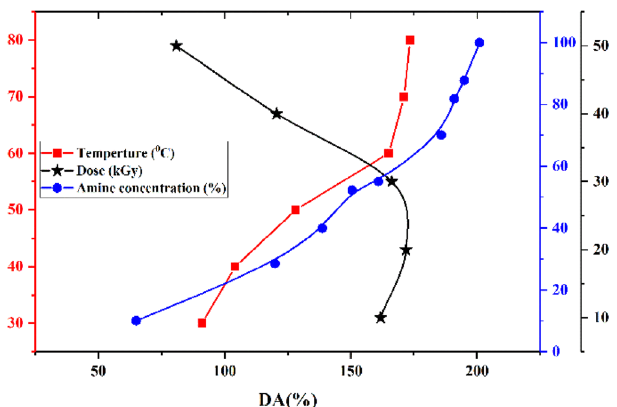
Figure 8. Effect of temperature, amine concentration and radiation dose on the degree of amination